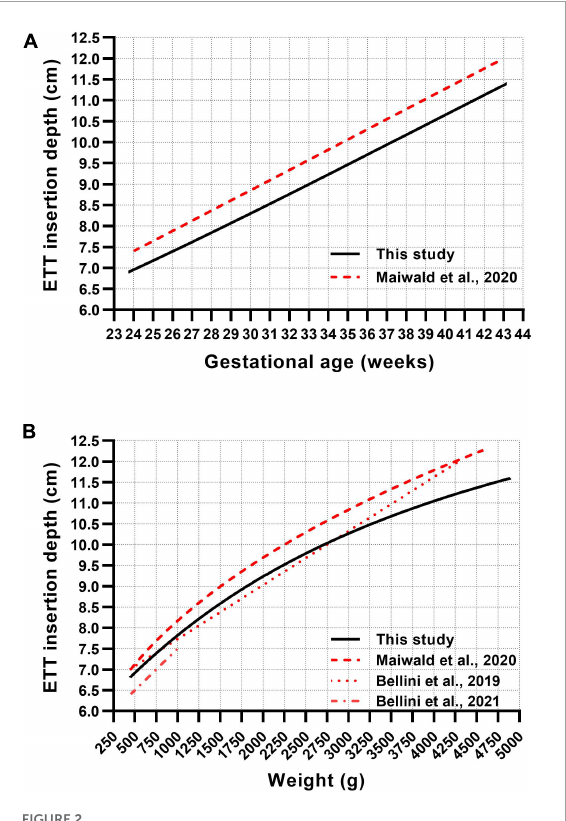
FIGURE2 Comparison between published gestational age-based (A) and weight-based (B) formulae and our generated curve charts for the recommendation of nasotracheal ETT insertion depths in